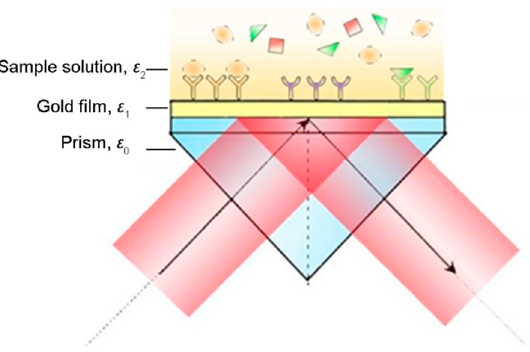
Figure 1. Kretschmann configuration used for surface plasmon resonance (SPR) sensing (Adapted from [24]).